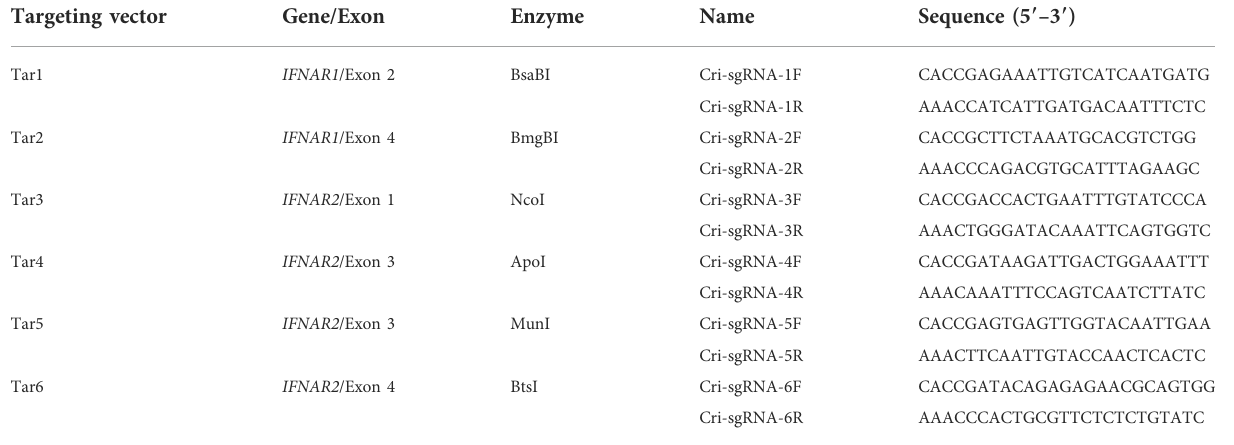
TABLE 2 DNA oligonucleotides for the construction of CRISPR/Cas9 targeting vectors. Targeting